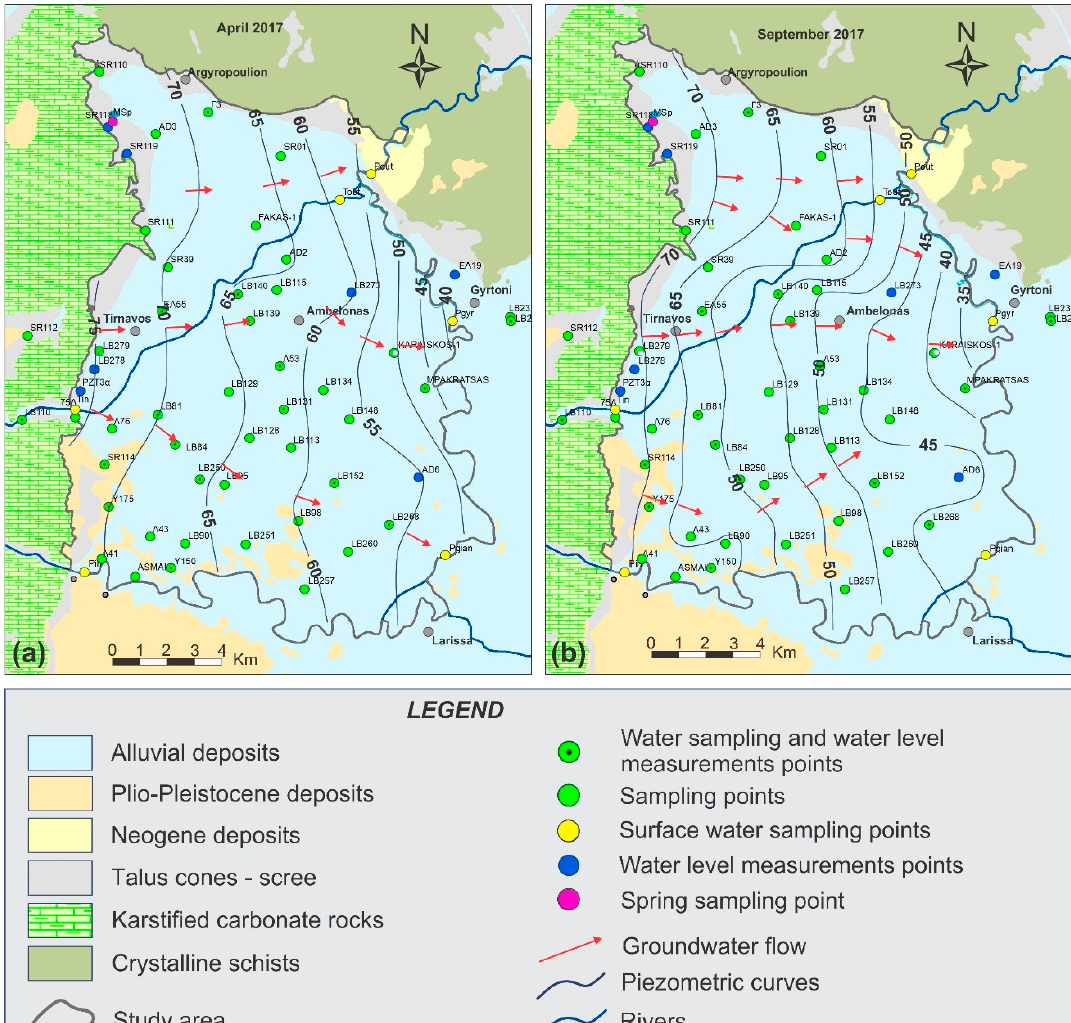
Figure 4. Monitoring network, piezometric curves and dominant flow lines for: ( a ) April 2017; and ( b ) September 2017 (Hydrolithology map based on [33]).